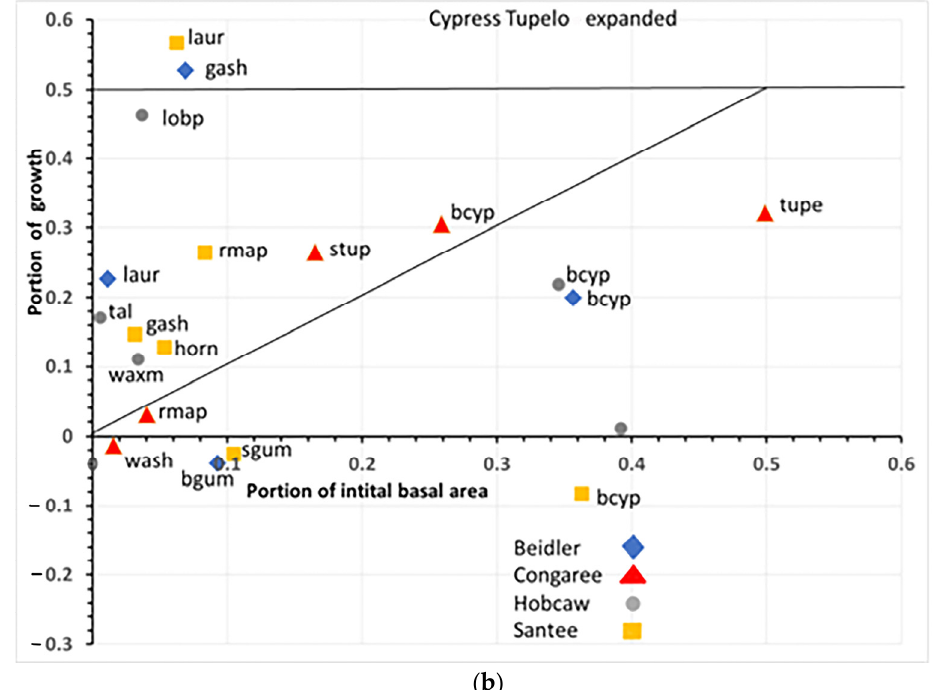
Figure 12. ( a ) Overall response of species in the cypress-tupelo type. Each species is labeled with four letter species code from Table 1 and symbols representing sites. ( b ) Enlargement of section of ( a ) (cypress-tupelo) near the origin in order to separate species codes.